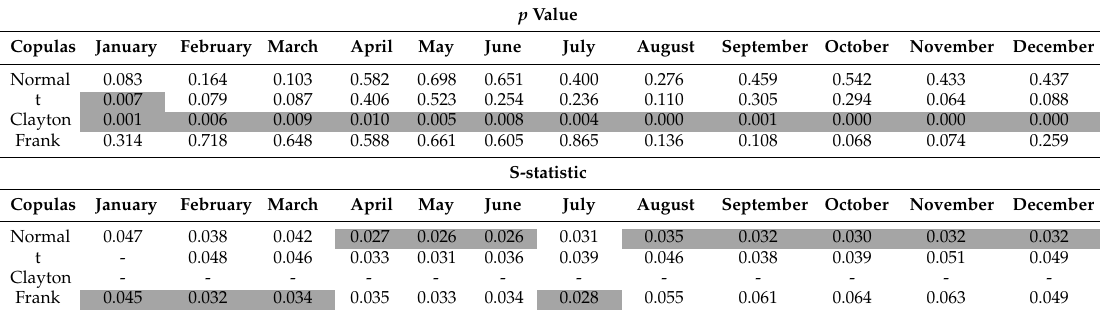
Table 6. p value and S-statistic leaving the third year out in cross-validation for the BNSO model. p Value